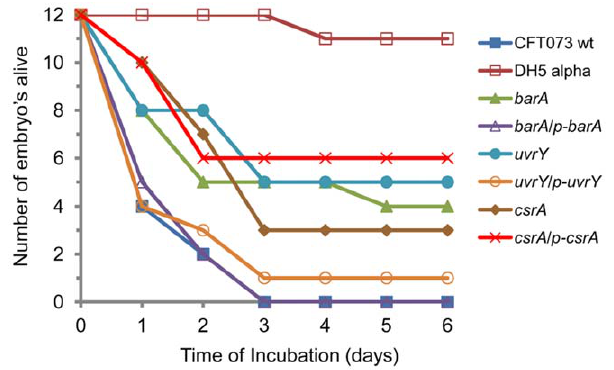
Figure 2. Chicken embryo infections by UPEC CFT073 and its mutant. A set of twelve 12-day-old SPF embryonated eggs were inoculated through allantoic cavity with 5 6 10 3 CFU of bacteria CFT073 N WT ( & ), DH5 aK 12 ( % ), SM3009 ( barA::cm ) ( m ), SM3012 ( barA/ p -barA ) ), SM3013 ( uvrY /p- uvrY ) carrying pSM1 ( D ), SM3010 ( uvrY::cm ) ( carrying pSM2 ( # ), SM3011 ( csrA::cm ) ( ¤ ) and SM3014 ( csrA /p- csrA ) carrying pSM7 (X). The results were scored as live, morbid or dead. The results were representative of two independent